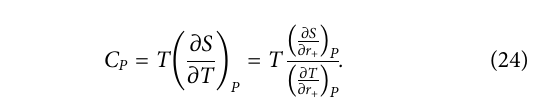
Frontiers in Physics |